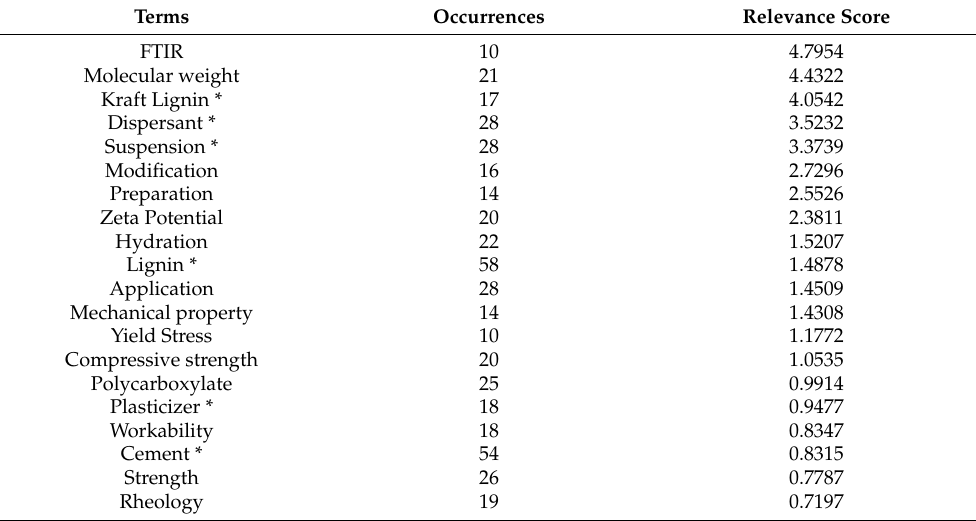
Table 5. Statistical analysis of relevant terms in the LBAs